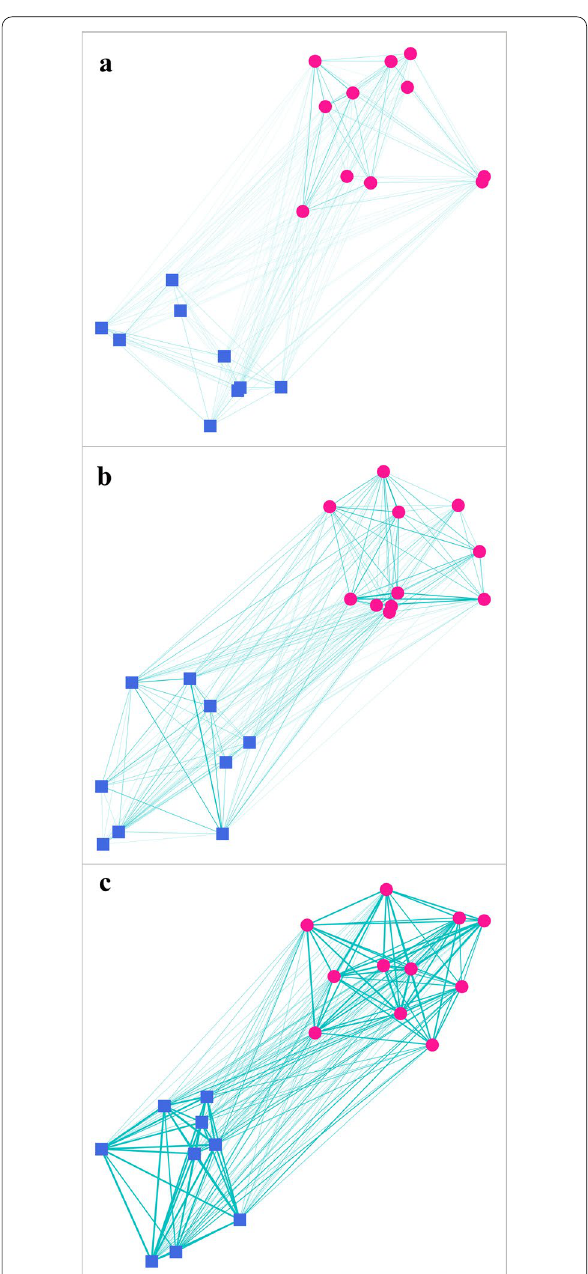
Fig. 5 Subject similarity networks of wood chips based on HS– GC–MS data ( a ), DART–MS data ( b ), and their fused SNF similarity network ( c ). Nodes represent wood samples (blue square: Pterocarpus santalinus ; red circle: Pterocarpus tinctorius ), edge thickness reflects the strength of the